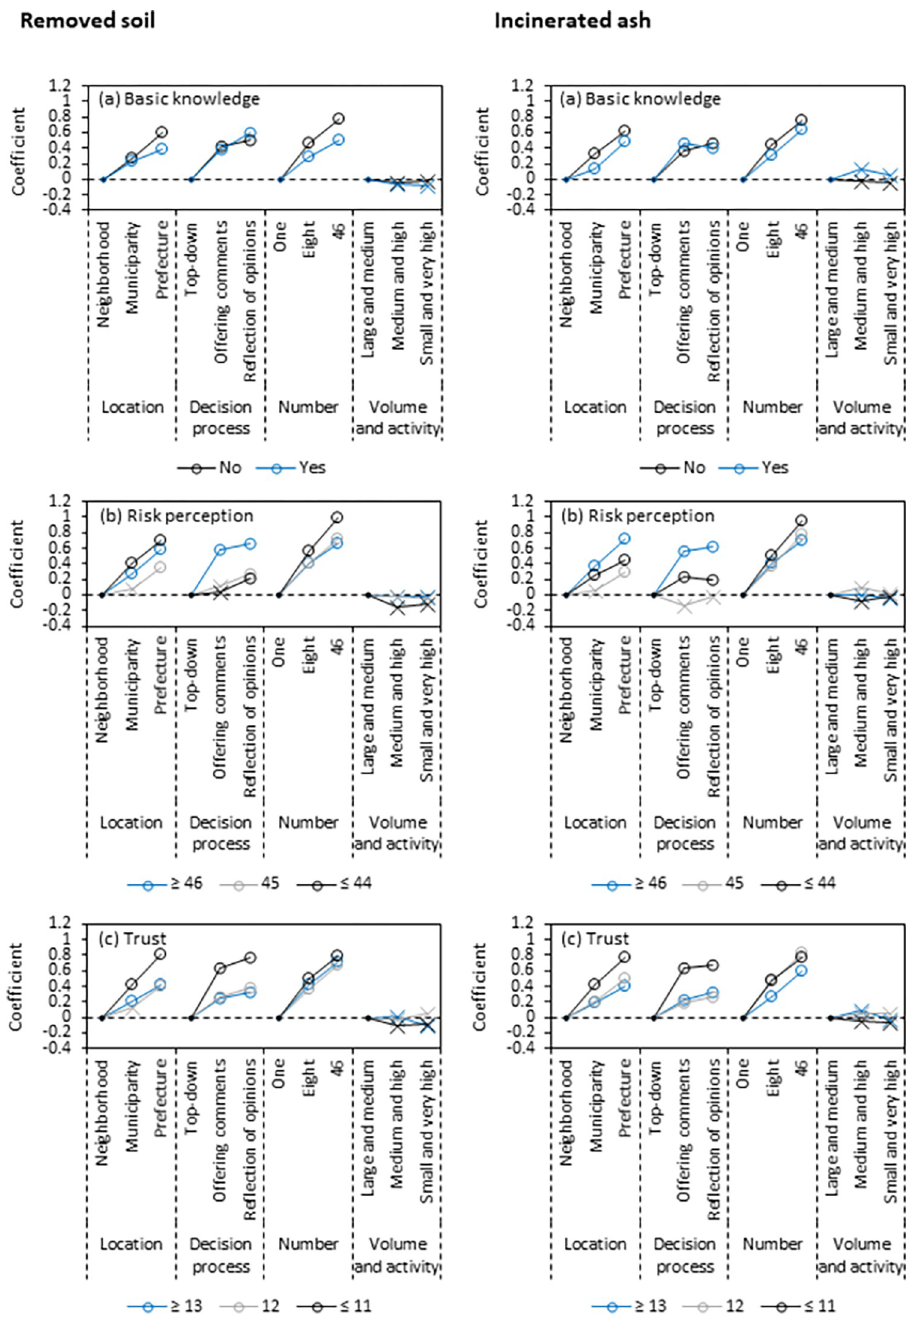
Fig 2. Coefficient estimates by response type for basic knowledge of final disposal, risk perception of health effects from radioactive materials, and trust in the Ministry of the Environment. The coefficients for neighborhood, top-down, one location, and no volume reduction (large and medium in volume and activity) were defined as references, and are shown by black circles in Fig 2. Open circles indicate statistical significance and cross marks indicate no statistical